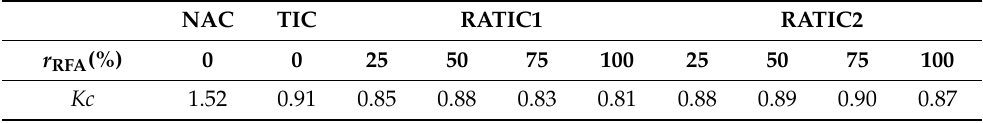
Table 8. Thermal conductivity of RATIC (W/(m·K)).